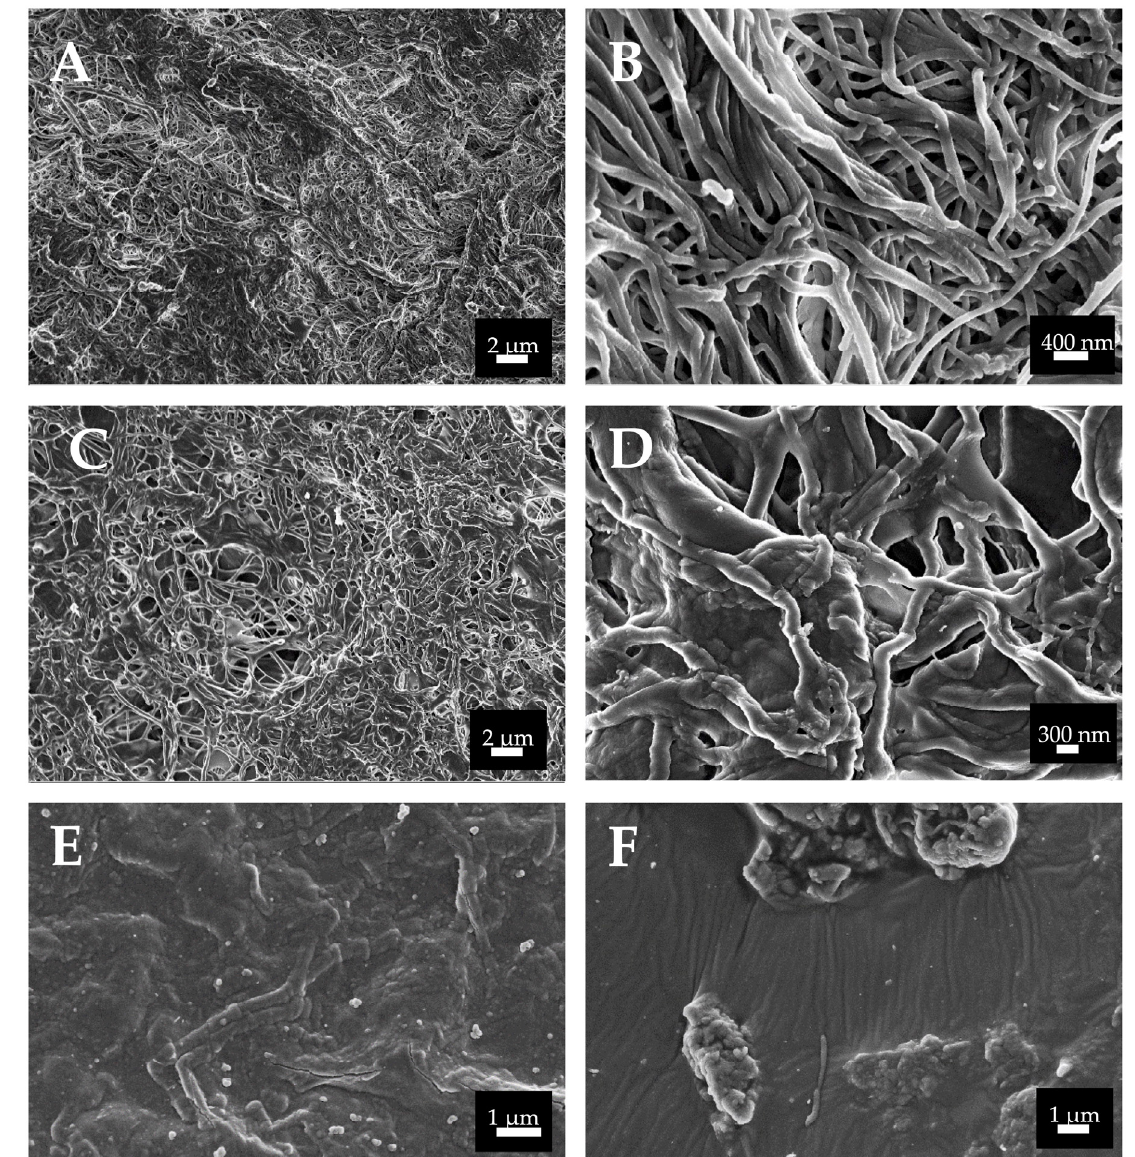
Figure 3. SEM images of the three membranes at the initial time-point. ( A , B ) Derma; ( C , D ) Evolution; ( E , F ) Duo-Teck. Randomly distributed collagen fibrils are found in Derma and Evolution membranes. Higher magnification of fibril bundles reveals the typical periodic banding pattern of collagen fibrils. Images have different magnifications (6000× to 40,000×).